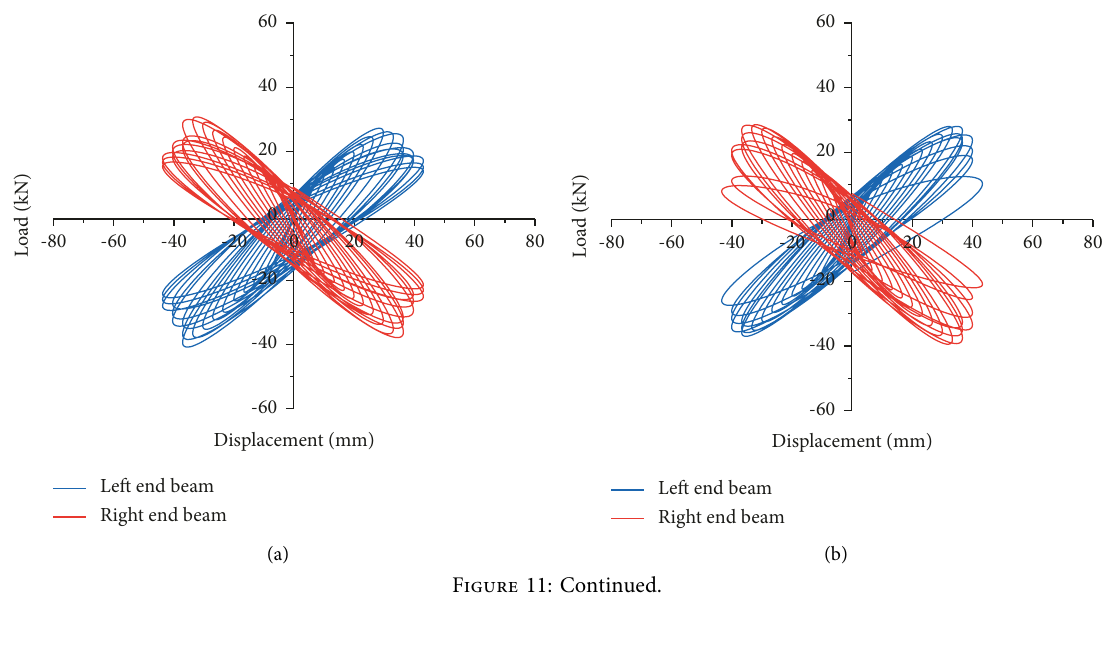
Left end beam Right end